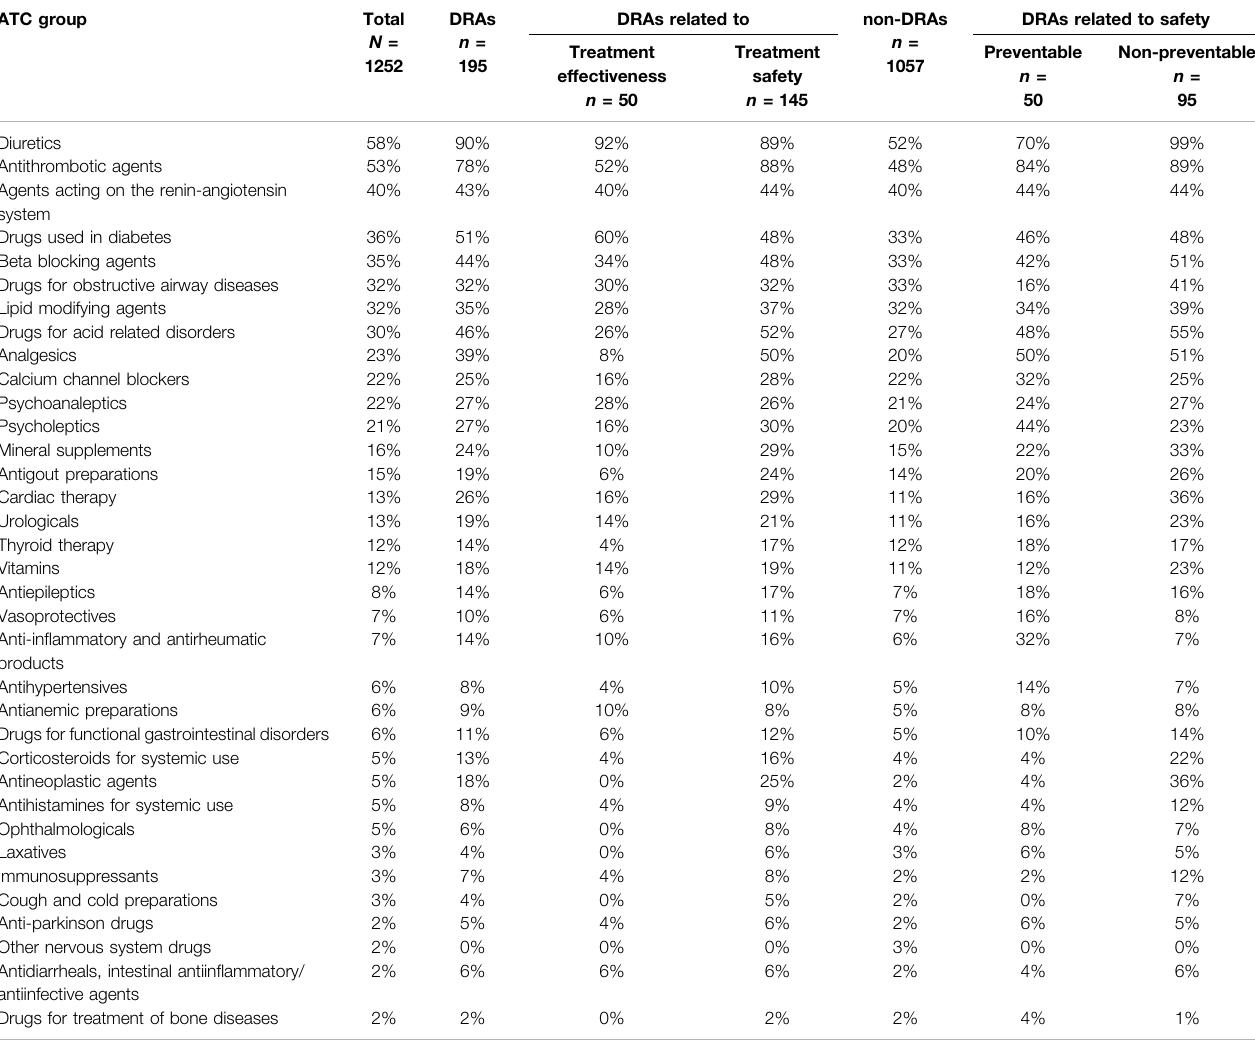
TABLE 3 | Baseline medications grouped by ATC group and inter-group differences. ATC